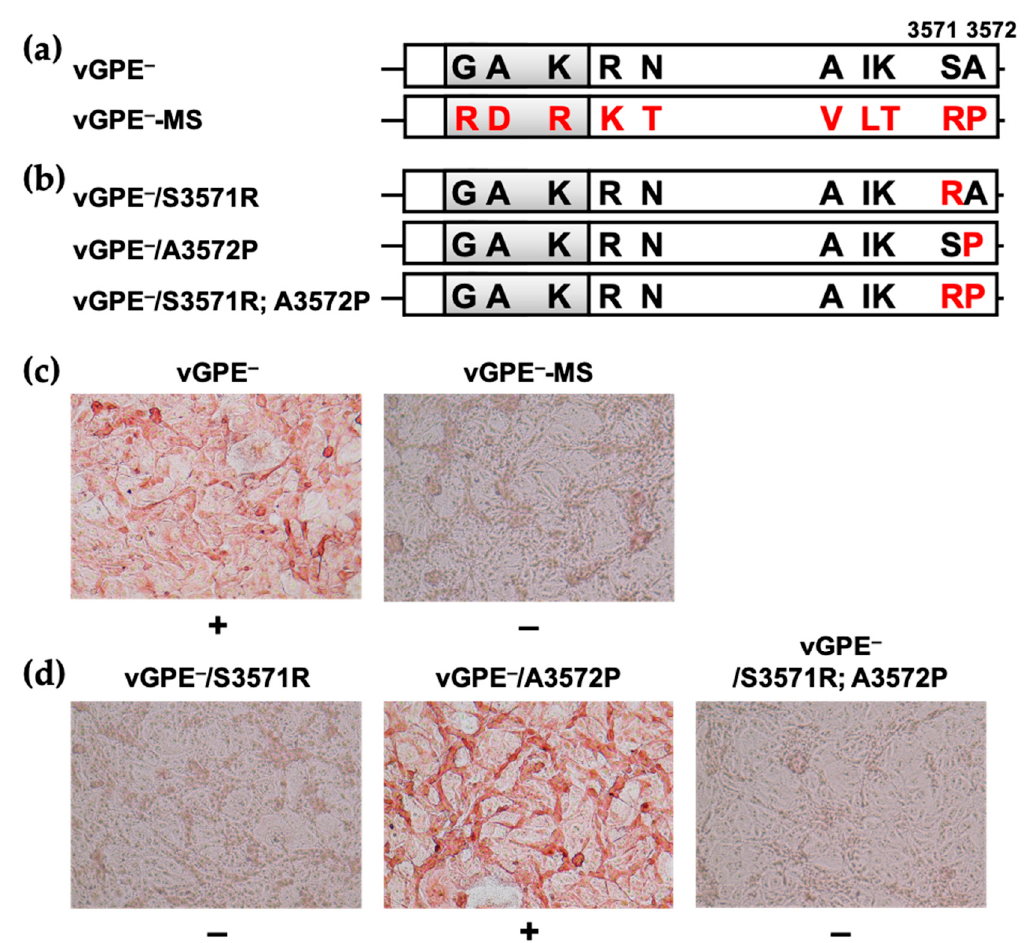
Figure 2. SK-L cells electroporated with in vitro-transcribed RNAs. The amino acid substitutions (red) were introduced in the backbone of vGPE − . ( a ) the viral genome of vGPE − -MS possesses the identical amino acid sequence to the master seed GPE − ; ( b ) three viral genomes of vGPE − /S3571R, vGPE − /A3572P, vGPE − /S3571R; A3572P possess substitutions in NS5B; ( c , d ) the in vitro-transcribed RNAs derived from the viral genomes above were electroporated into SK-L cells. After 72 h, the cells were heat-fixed and immunostained using the anti-NS3 mAb, 46/1. + depicts that the antibody reacted with the viral NS3 proteins: the success of virus rescue.—depicts that the antibody did not react with the viral NS3: failure of virus rescue. The original magnification was ×200.